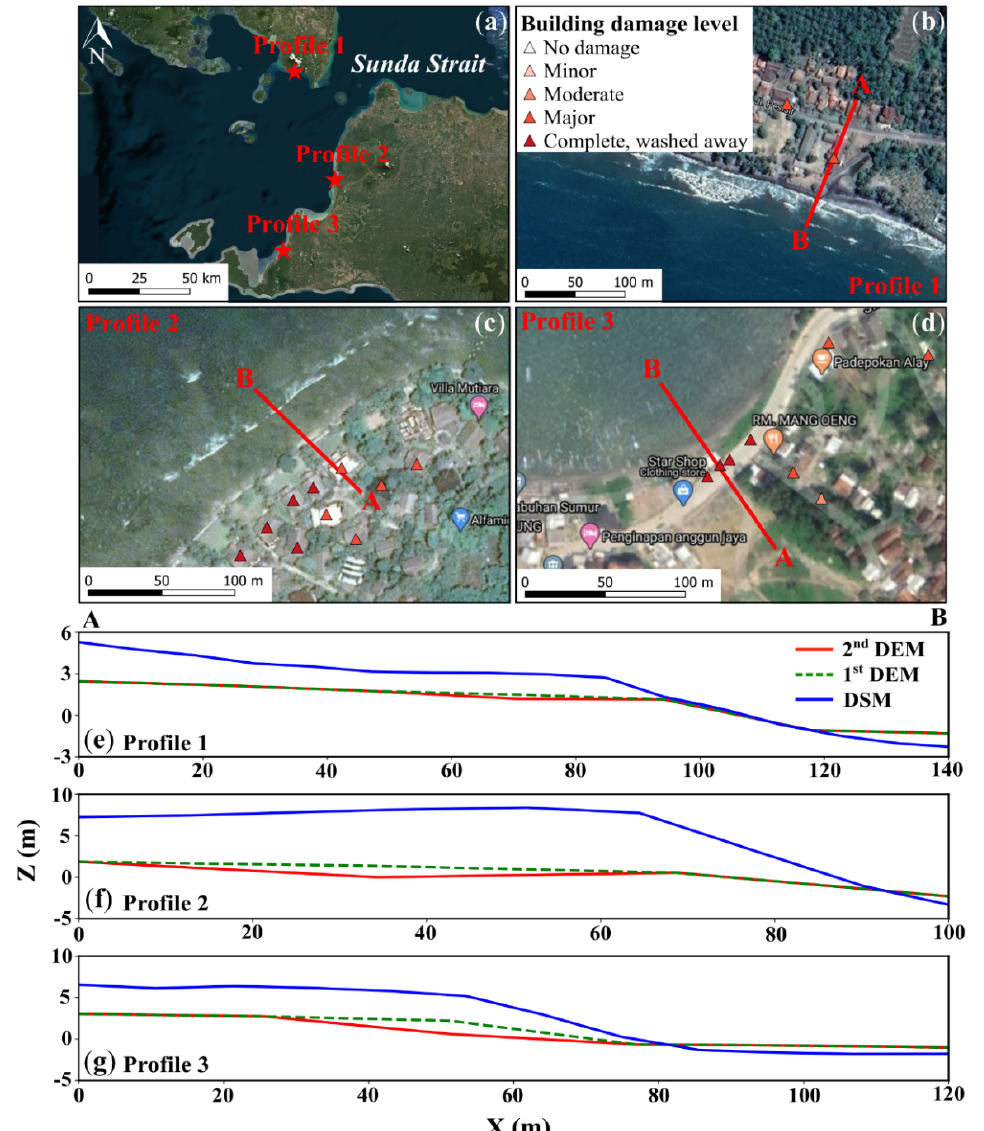
Figure 4. (a) Cross sections along Sunda Strait coasts. One cross section is realized in the computational areas (b and e) 1, (c and f) 2, and (d and g) 3 to illustrate the topographic corrections applied to the DSM at buildings using QGIS (a triangle represents a building) (background ESRI and © Google